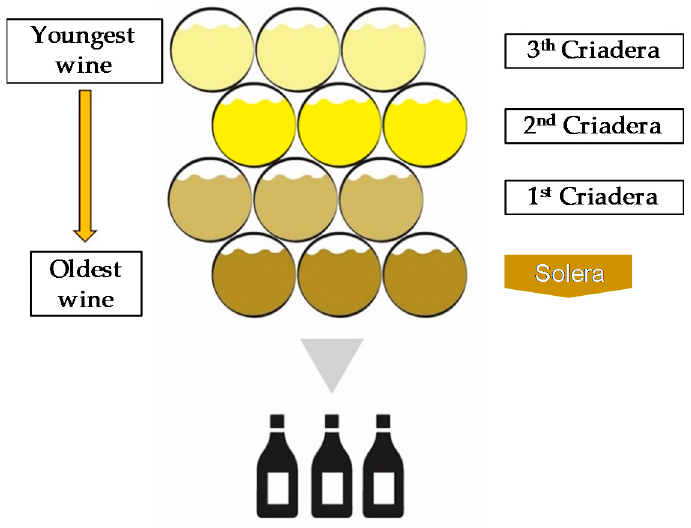
Figure 3. Sherry and Port’s winemaking processes.